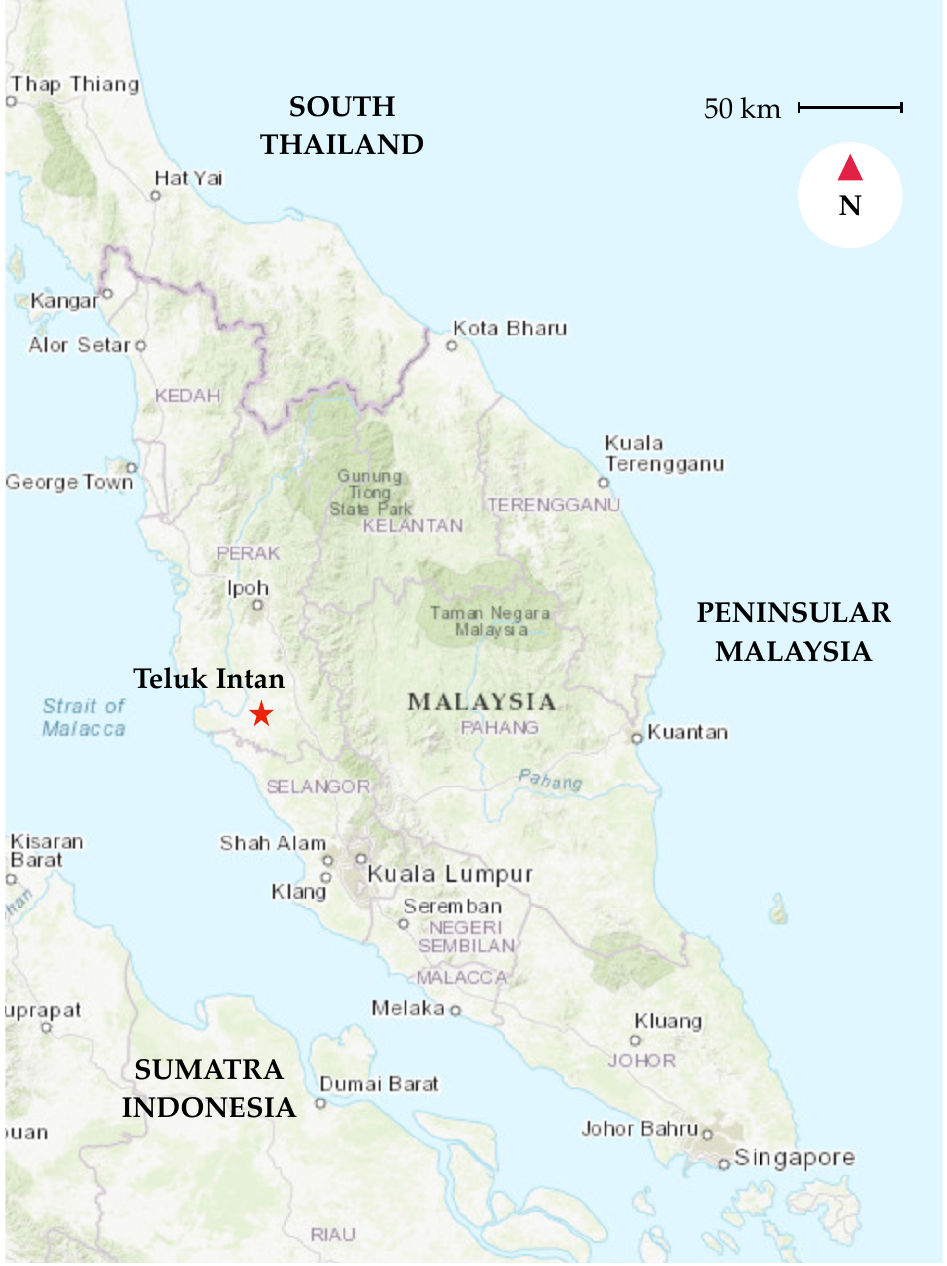
Figure 1. Map of Peninsular Malaysia showing the location of Teluk Intan (red star) within the State of Perak. Accessed on 13 May 2019 from